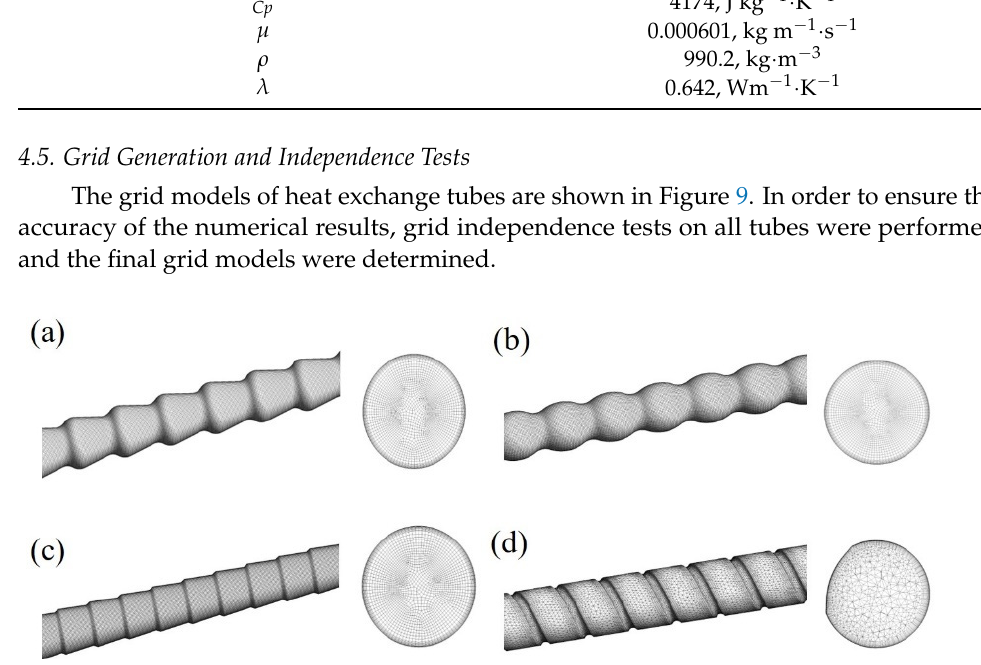
Figure 9. Grid models of HEHE tubes: ( a ) conically corrugated tube; ( b ) arc-corrugated tube; ( c ) converging-diverging tube; ( d ) spiral grooved tube. ( c ) converging-diverging tube; ( d ) spiral grooved